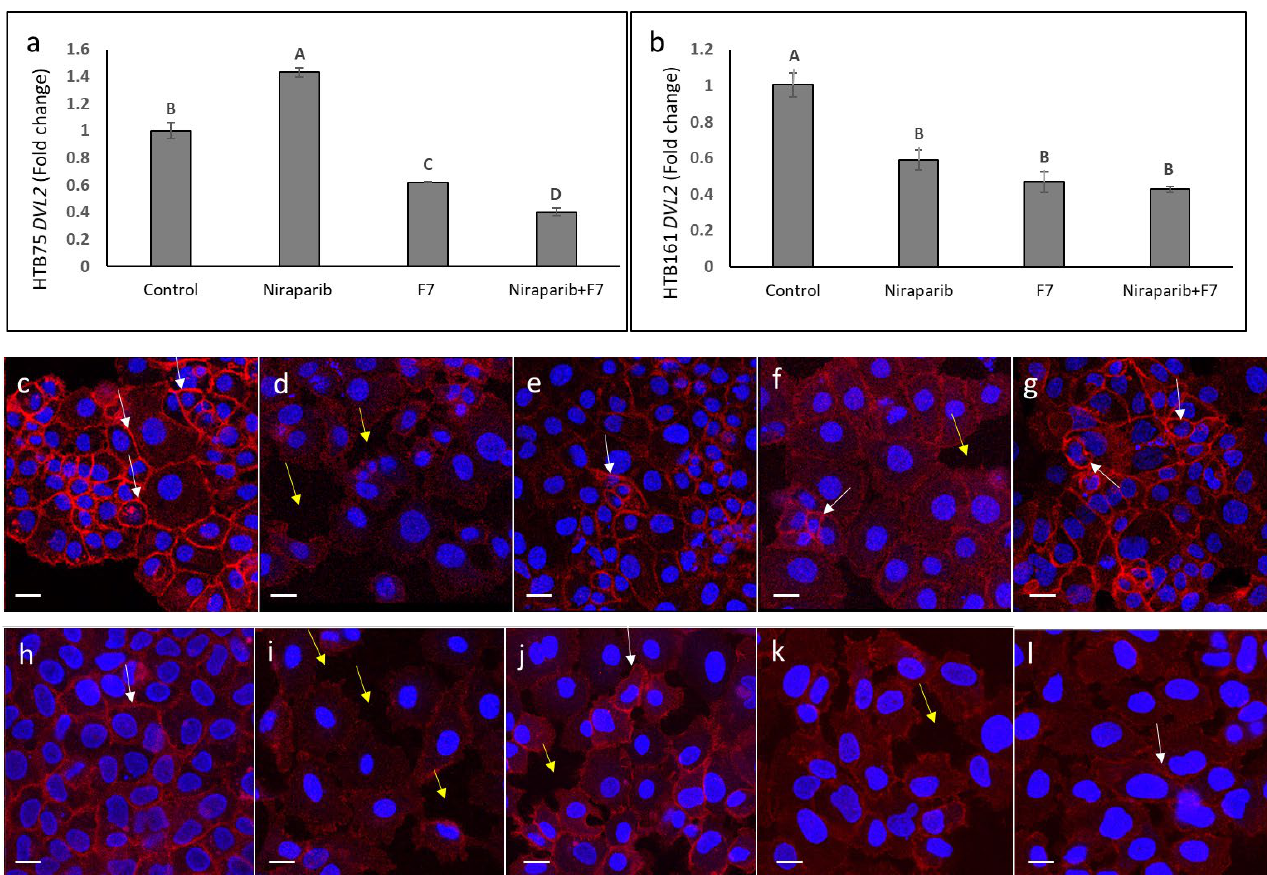
Figure 11. Quantitative PCR-based determination of the RNA steady state level in HTB75 ( a ) and HTB161 ( b ) cell lines of members of DVL2 at 6 h of treatment with niraparib (at 6 or 25 µg/mL for HTB75 and HTB161, respectively), F7 (at 17.5 or 20 µg/mL for HTB75 and HTB161, respectively) or a combination of niraparib+F7 (6 + 17.5 and 25 + 20 µg/mL for HTB75 and HTB161, respectively), relative to control. Gene transcript values were determined by quantitative PCR as a difference between the target gene versus a reference gene (HPRT). Values were calculated relative to the average expression of target genes in treated versus control using the 2 −ΔΔCt method. Control was the vehicle control (1.00% v/v methanol + 0.60% v/v DMSO). Error bars indicate ± S.E. ( n = 3). Levels with different Upper case letters with the same font and style were significantly different from all combinations of pairs by Tukey-Kramer honest significant difference (HSD; p ≤ 0.05). Representative examples of confocal images of HTB161 ( c – g ) and HTB75 ( h – l ) non-induced ( c , h ), induced cell treated with vehicle control (0.6% methanol + 0.3% DMSO and 0.7% methanol + 0.88% DMSO respectively; ( d , i ), induced cells following treatment with niraparib (3 and 17.5 µ g/mL respectively; ( e , j ) or F7 (3 and 14 µ g/mL, respectively; ( f , k ) and niraparib+F7 (3 + 3 and 17.5 + 14 µ g/mL, respectively; ( g , l )). β -catenin was detected using β -catenin monoclonal antibody PE, REAfinity™ (red color) and nuclei, stained using EasyProbes™ Hoechst (blue stain); n = 3, in each biological replicate multiple cells, were examined. Bars denote 20 µ m. White arrows denote β -catenin signaling in cell membranes; yellow arrows denote spaces between cells in the